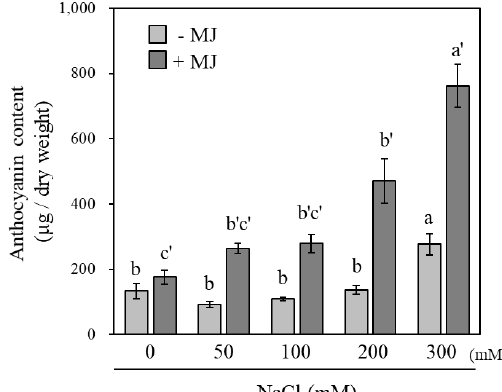
Figure 4. Effect of NaCl concentration on anthocyanin accumulation in radish sprouts co-treated with MJ. Anthocyanin contents were measured after exposure to 0, 50, 100, 200, or 300 mM NaCl with or without 0.5 mM MJ treatments. Vertical bars represent ± SE ( n = 6). Significant differences were detected by Tukey’s multiple comparison test ( P < 0.05). Statistical analyses were performed separately for the sprout with or without MJ treatment, and results are shown by lower-case letters without and with single apostrophes, respectively.